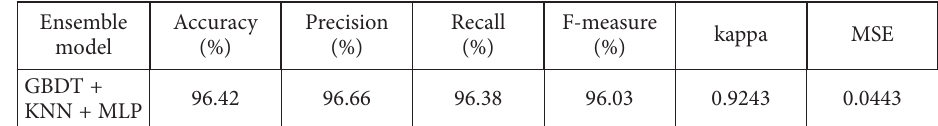
Table 6. Results of ensemble